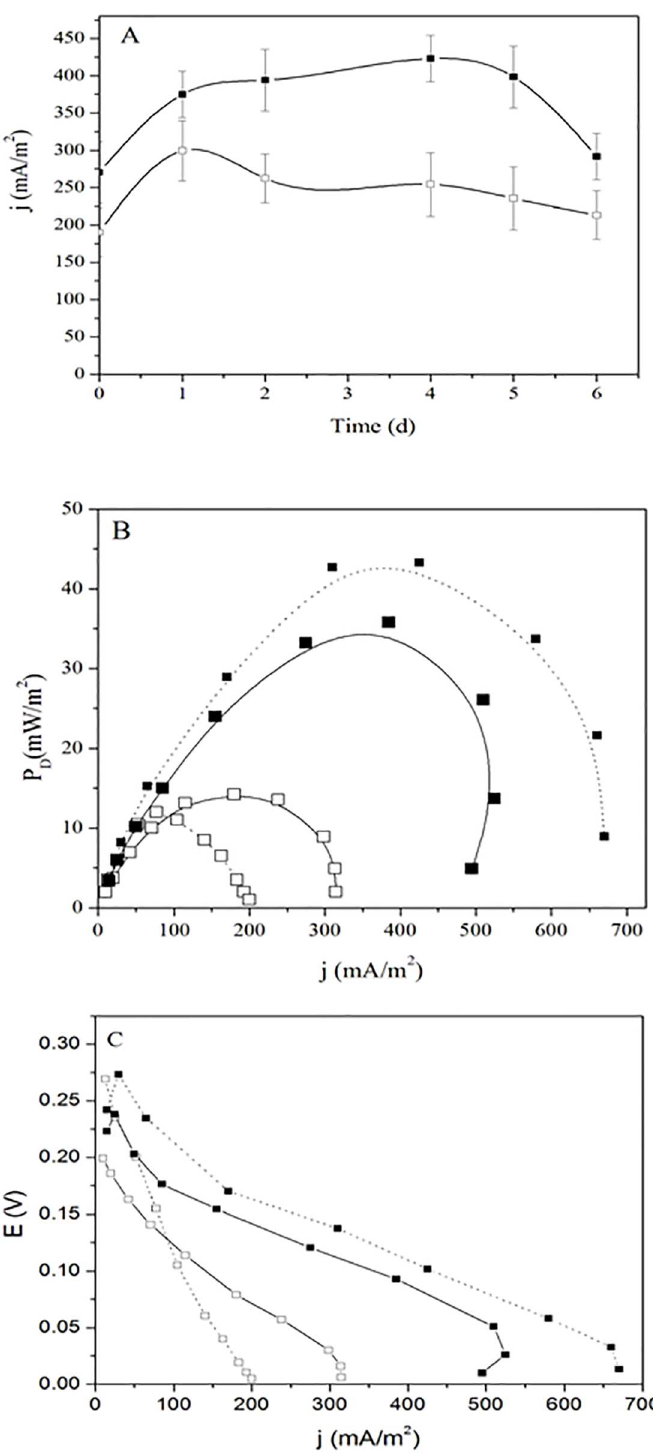
Fig 6. MFC experiments and bacterial strain comparison. (A) Current density vs. time measuredfrom a MFC S ( S . oneidensis MR-1, closed squares)and from a MFC D (Dietzia sp. RNV-4 (openedsquares).n = 3, R L = 4.68 k Ω . (B) Power density curves from the MFC S (closedsimbols squares) and MFC D (openedsquares) made after 1 (solid line) and 4 (dash line) days incubation.(C) Comparisonof polarization curves from the MFC S (closed squares)and MFC D (openedsquares) made after 1 (solid line) and 4 (dash line) days